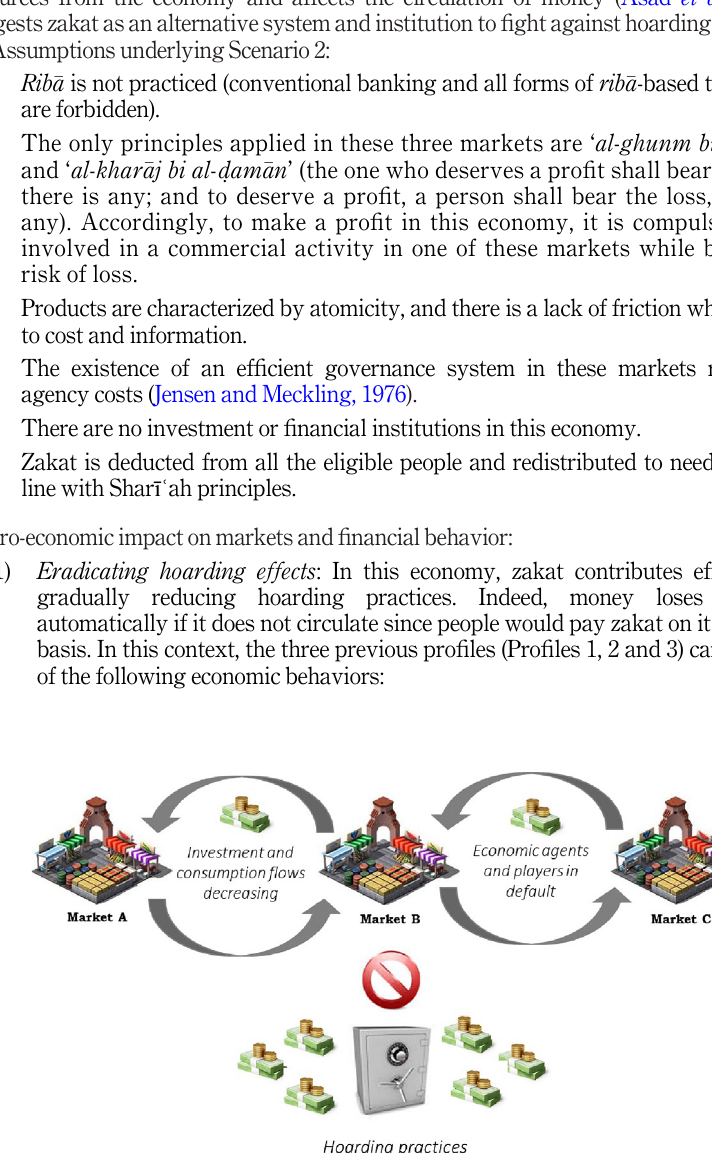
Figure 2. Scenario 1 – a rib (cid:1) a - free